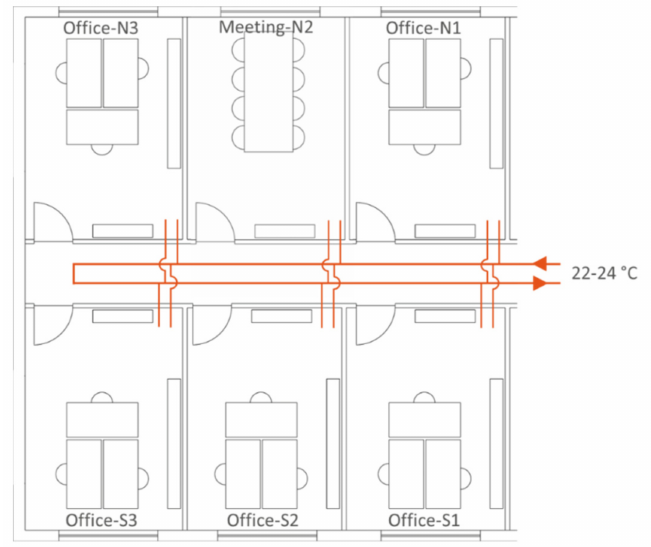
Figure 5. Generic office building with room names and layout of two-pipe water supply. Both South and North-oriented spaces are supplied with the same water temperature and the same flow